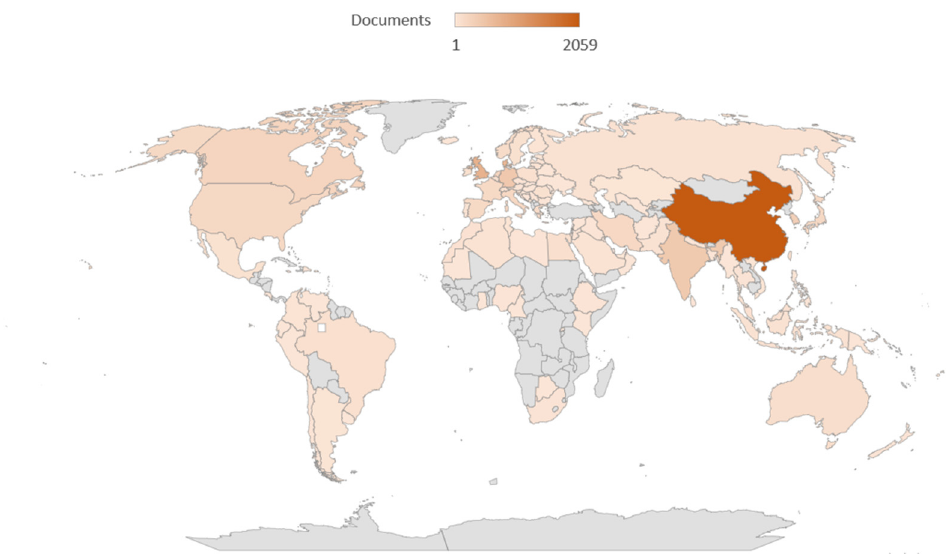
Figure 1. Worldwide top ten countries on optimizing wind turbine efficiency.